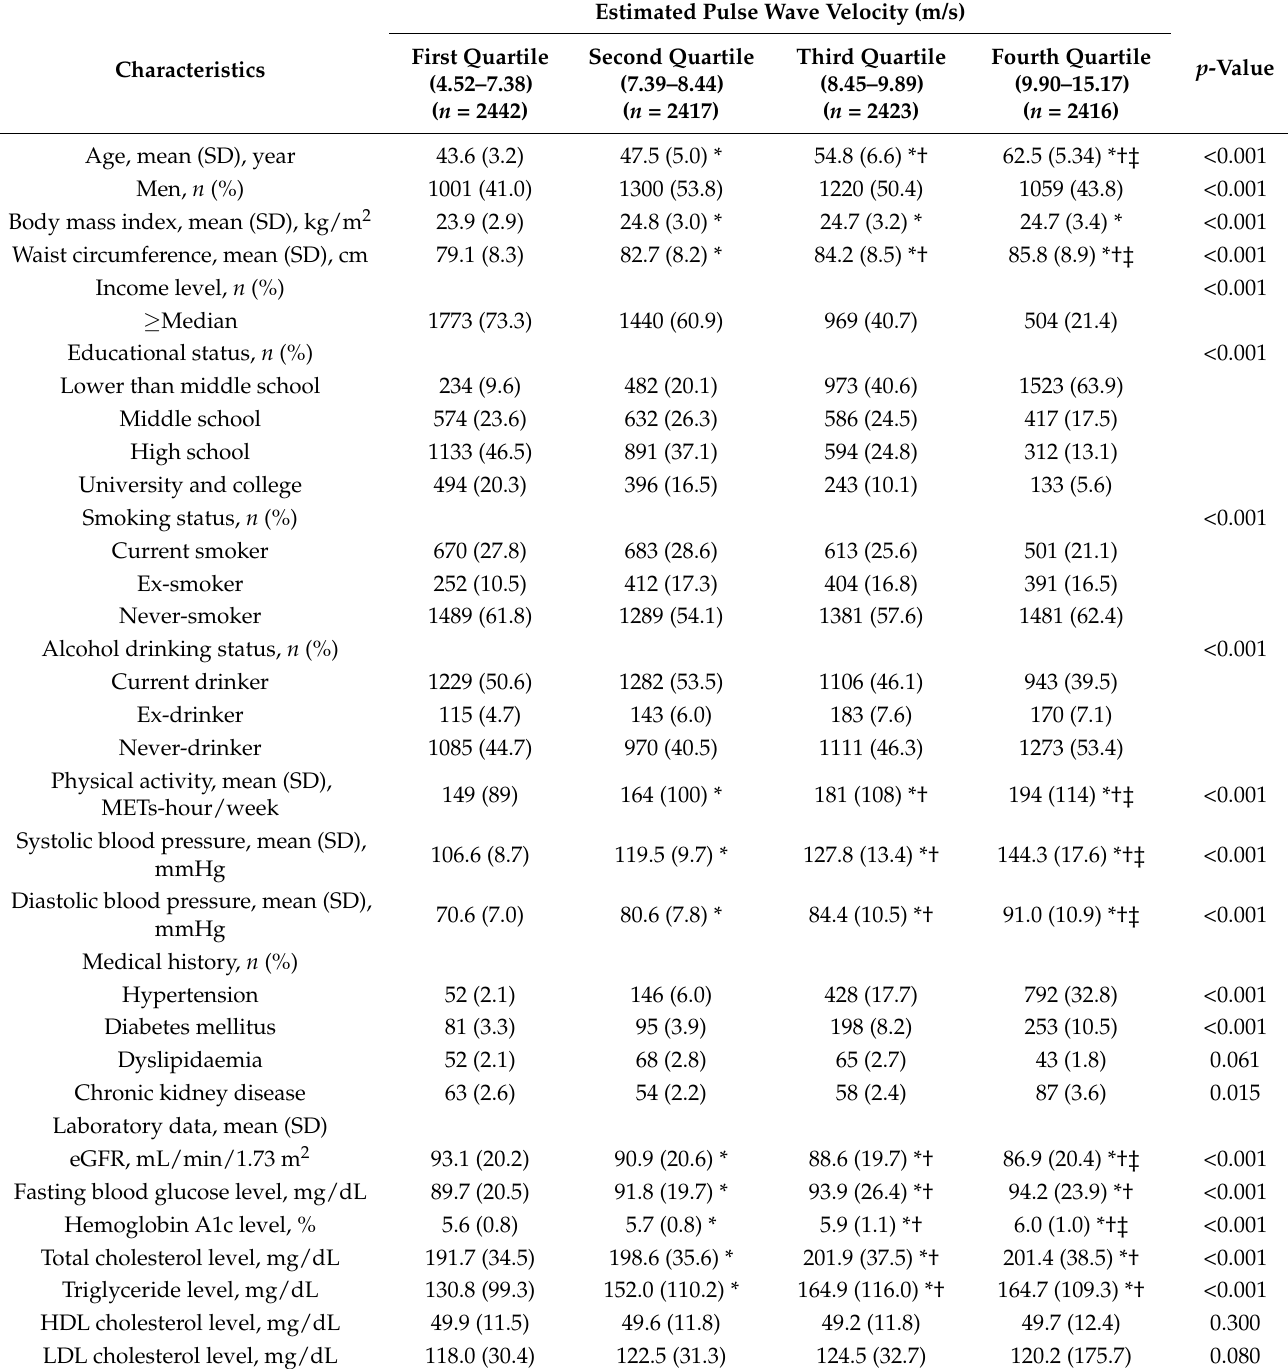
Table 1. Baseline